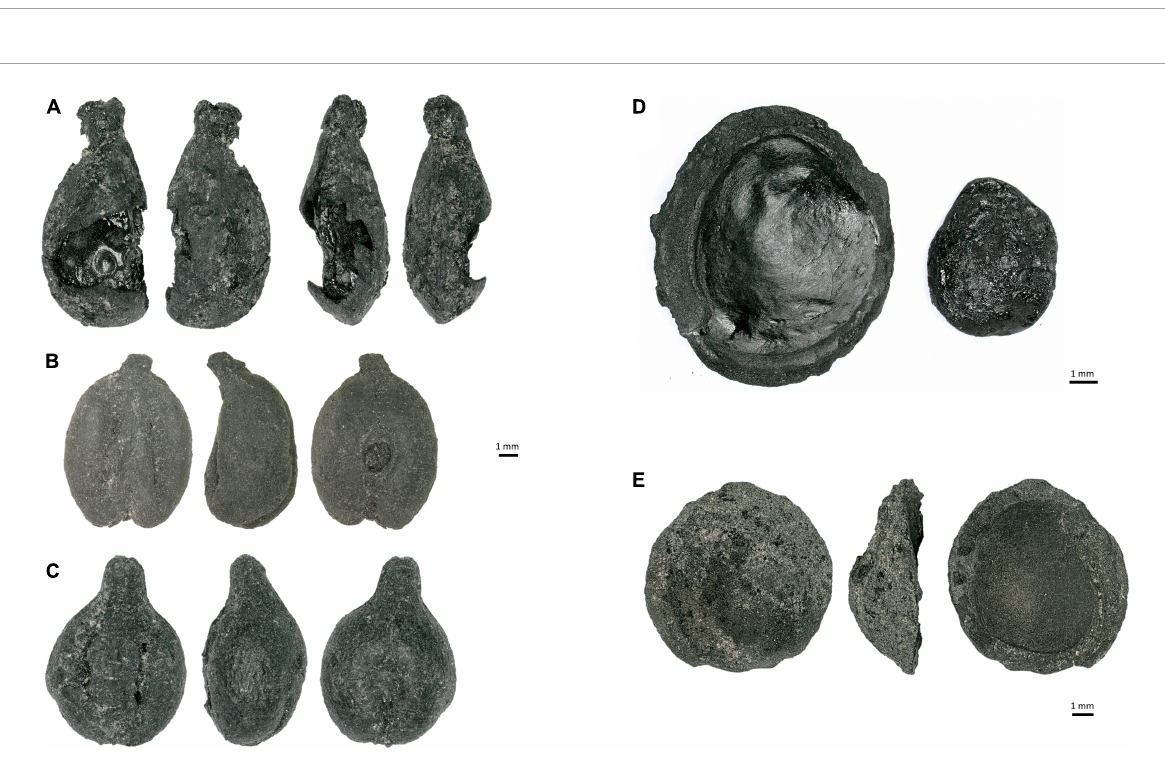
Frontiers in Ecology and Evolution